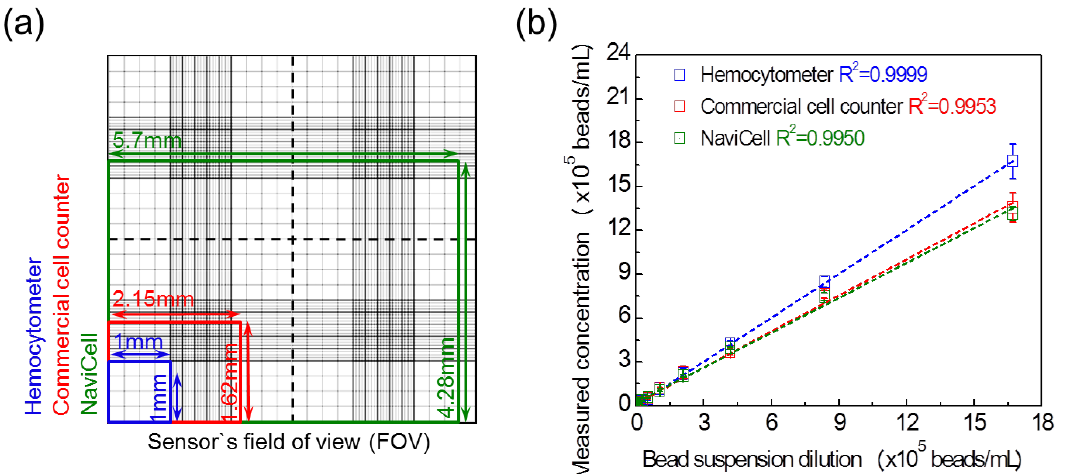
Figure 3. Advantages of the NaviCell platform. ( a ) FOVs of the three different measurement methods used in the experiment are superimposed for easy comparison. Blue box shows the FOV of a hemocytometer, red box shows the FOV of the commercial cell counter and green box shows the FOV of the NaviCell; ( b ) To measure 10 μm beads with various concentrations, the average standard deviation of the hemocytometer (blue line), the commercial cell counter (red line) and the NaviCell (green line) are 2.3 × 10 4 , 2.1 × 10 4 and 1.1 × 10 4 beads/mL, respectively.